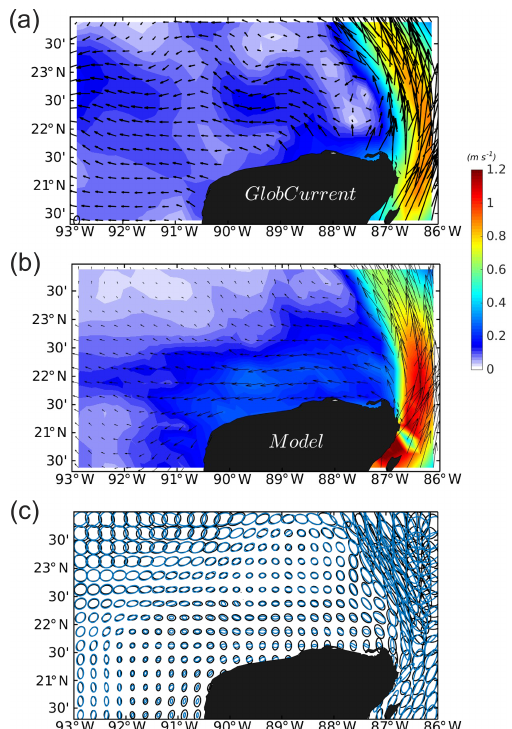
Figure A8. Mean current magnitude and velocity vectors averaged for the years 2002 to 2010 in metres per second. (a) Mean geostrophic plus Ekman currents from the GlobCurrent product. (b) Mean total current from the model; (c) velocity variability ellipses of the GlobCurrent product (black) and model outputs (blue).